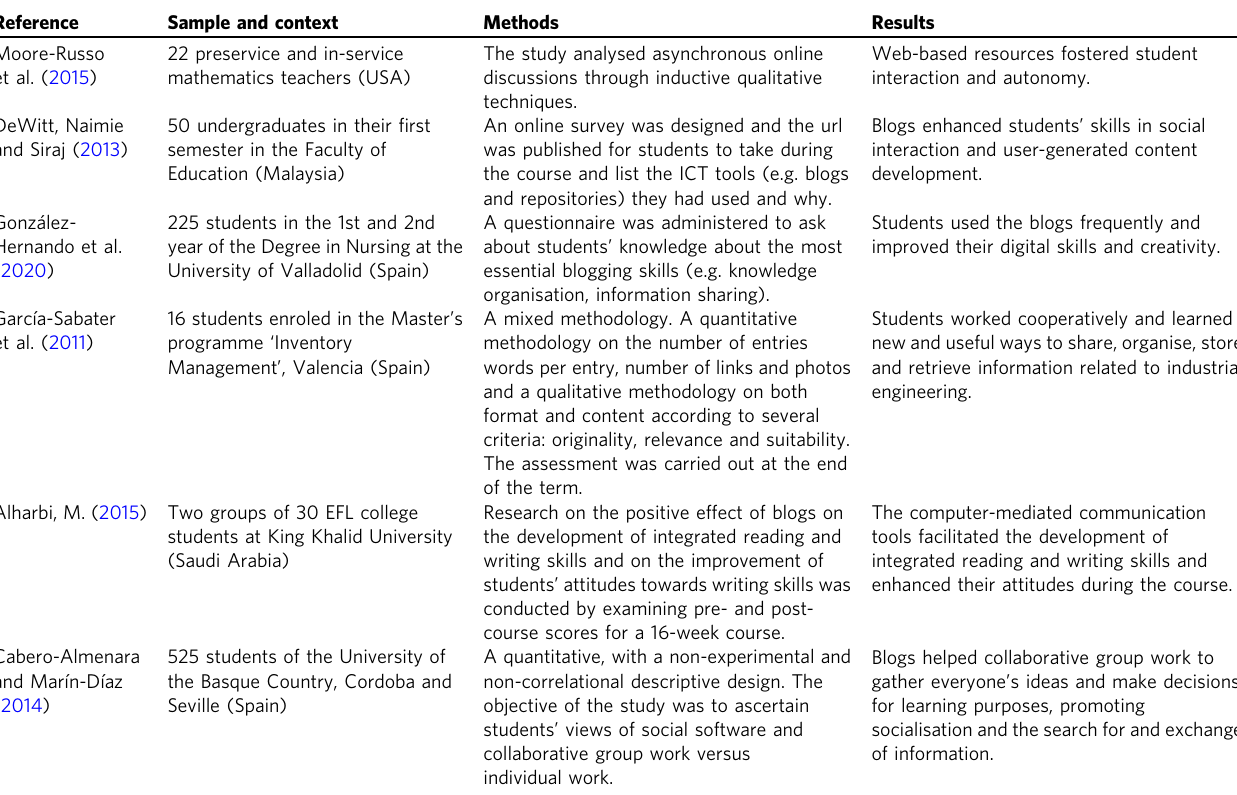
Table 1 Advantages of the blogging activity in higher